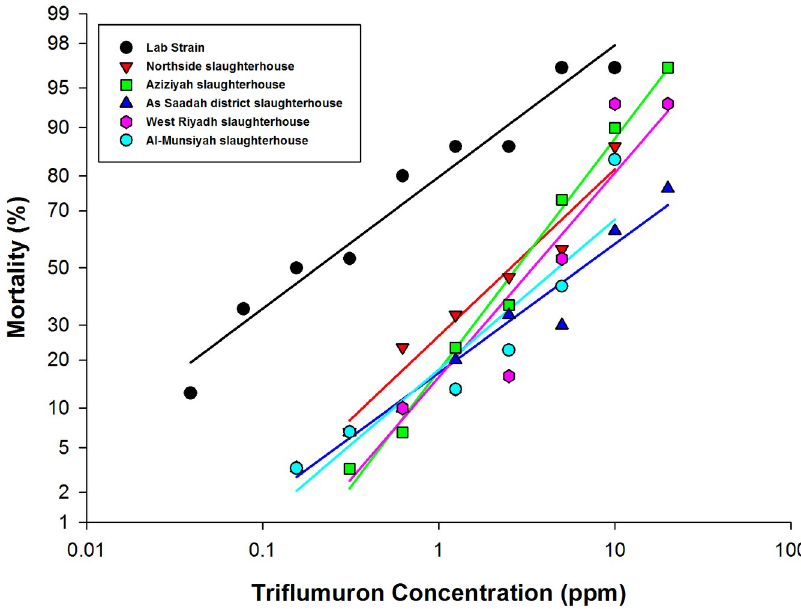
Fig 1. Mortality induced by exposing 3 rd instar larvae of M . domestica L. to triflumuron. Larvae were fed different IGR concentrations, and the cumulative mortality was calculated after 14 days of exposure.